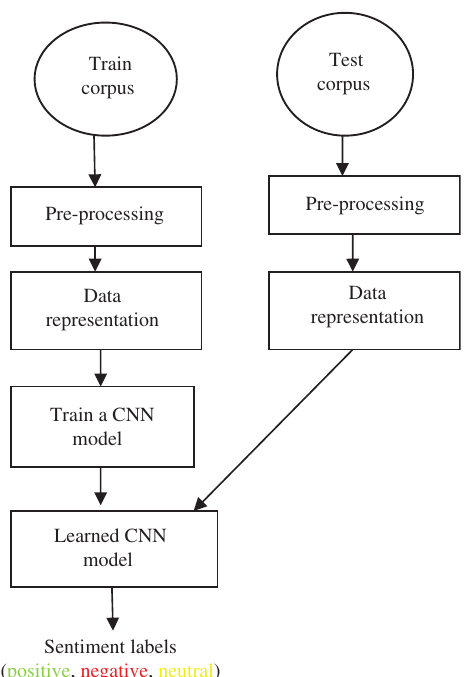
Figure 2: Block Diagram of Our Proposed